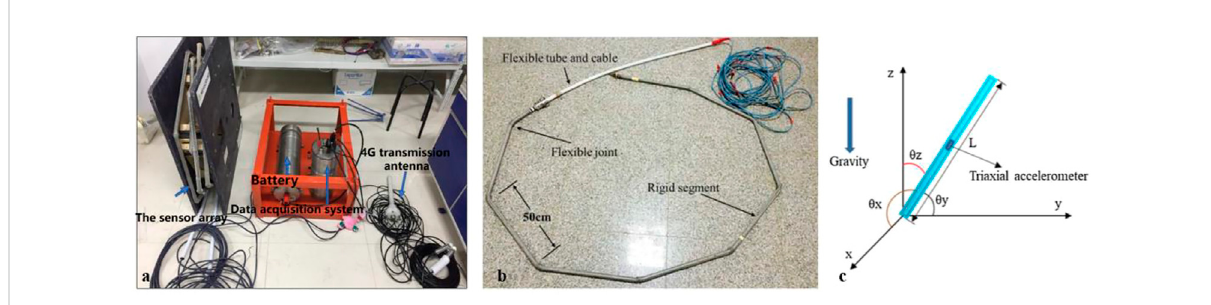
FIGURE 4 Seabed deformation observation system and working principle. (A) Shows the physical map of the seabed deformation observation system, (B) shows the physical map of sensor array, and (C) shows the sketch map of the single shape accel array